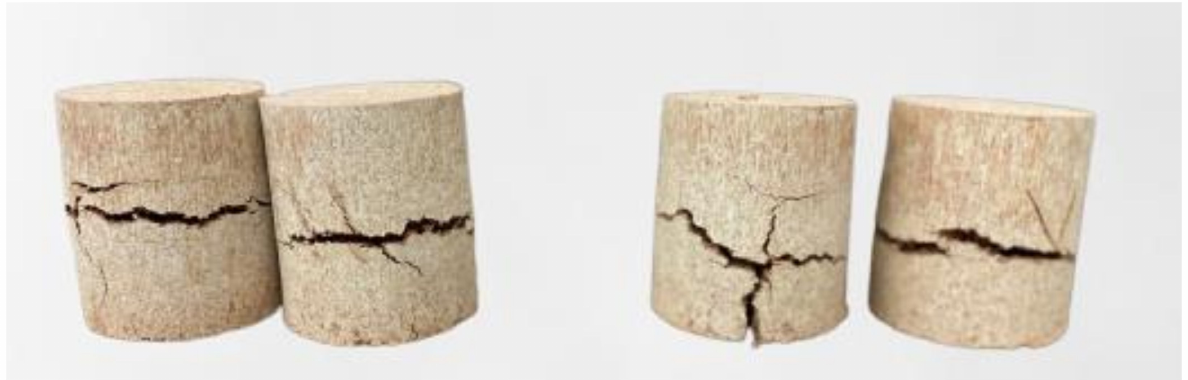
Figure 4. The samples with bentonite after burning at 1100 ◦ C for 1 h.